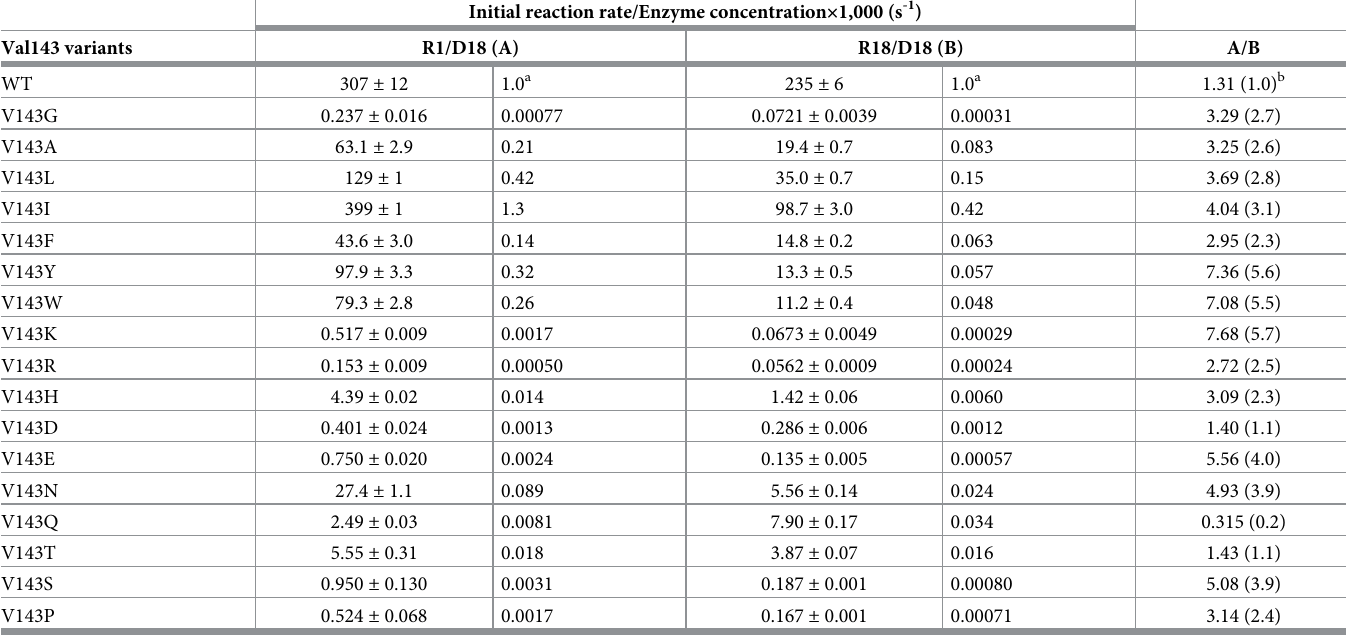
Table 1. Activities of Val143 variants.